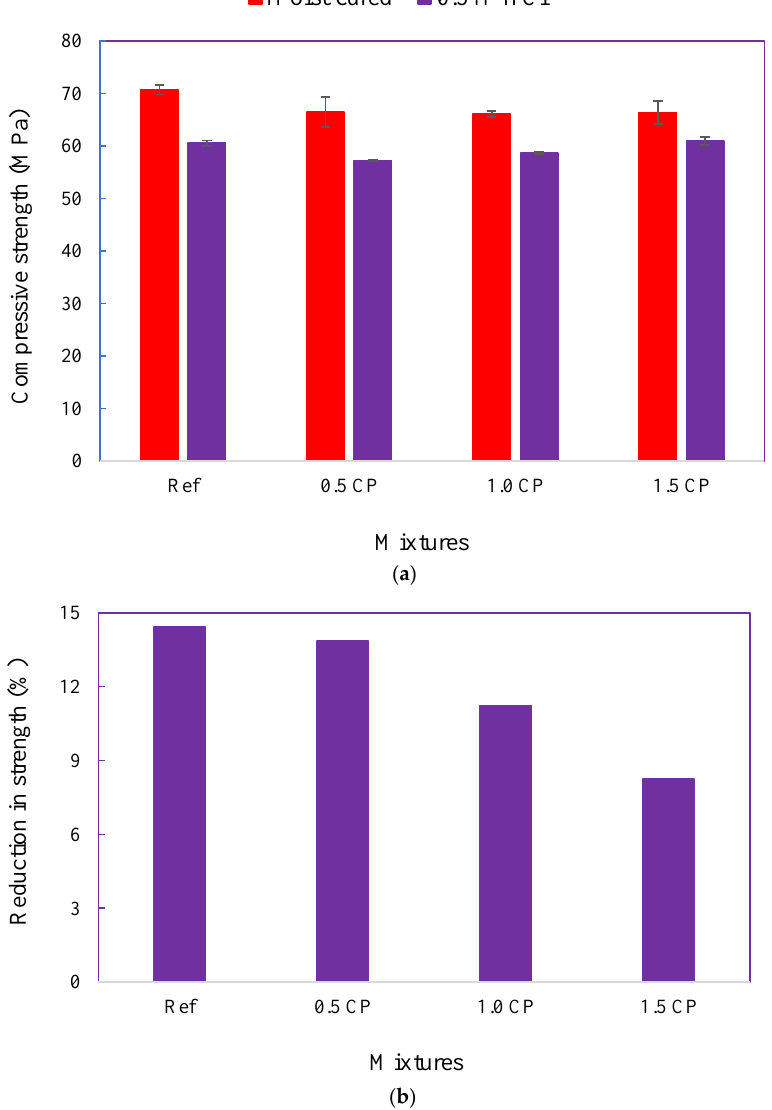
Figure 9. ( a ) Twenty-eight-day compressive strength of specimens exposed to moist curing and 0.5 M HCl solution. ( b ) Relative reduction in the compressive strength after acid attack.